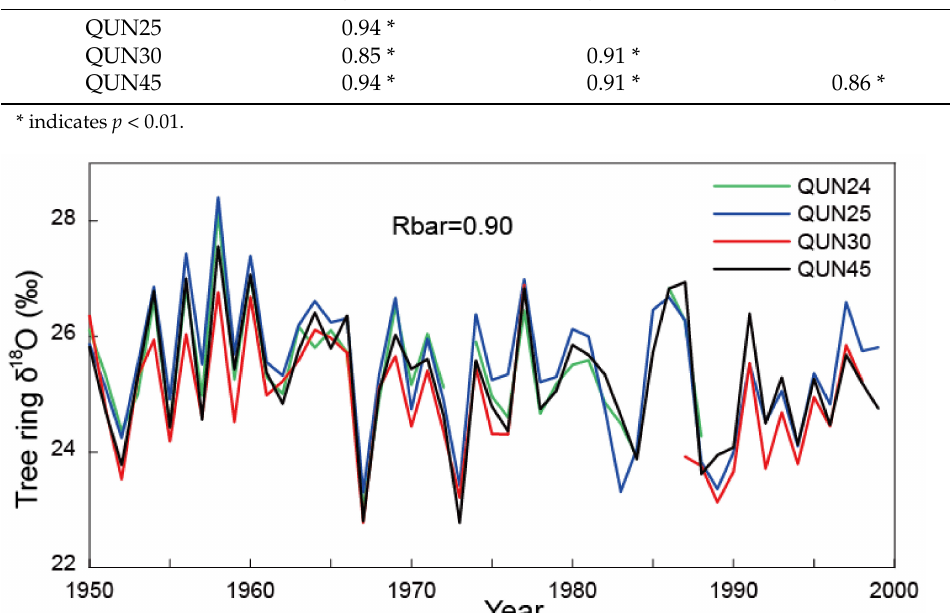
Figure 2. Tree ring oxygen isotope time series from four birch during the period of 1950–1999 . Because δ 18 O shows consistent between-tree variations, we developed a regional δ 18 O chronology ( δ 18 O GTR ) by averaging the four δ 18 O time series (QUN 24, 25, 30 and 45). The first-order autocorrelation for δ 18 O GTR is low (0.01), which indicates the tree ring δ 18 O of the current year is little affected by the tree ring δ 18 O in previous